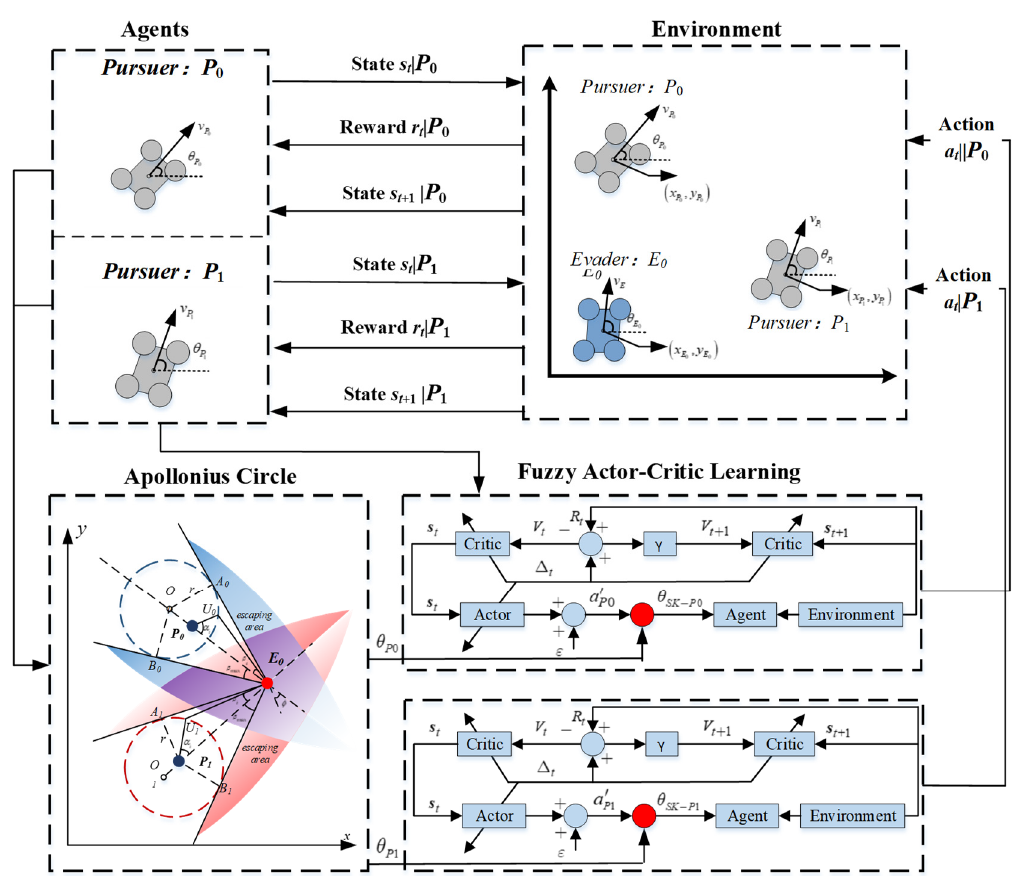
Figure 4. The overall design diagram of the SK-FACL.